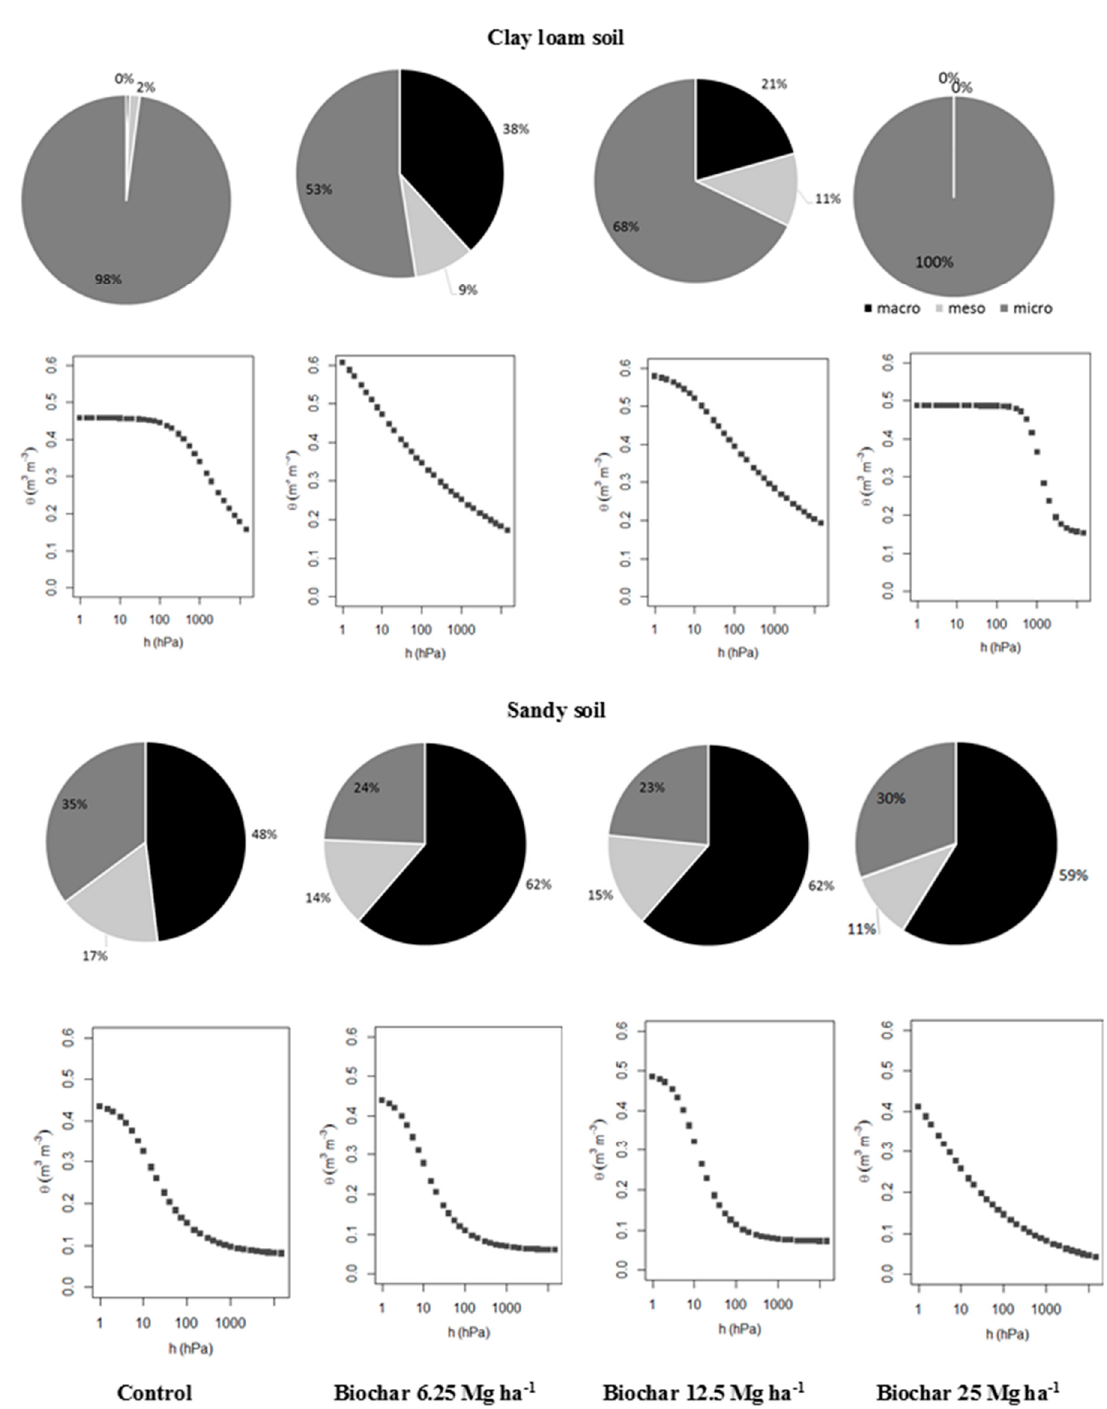
Figure 6. Effect of biochar amount on macropores (>50 µm); mesopores (15–50 µm) and micropores (<15 µm), and its relation with water retention. (<15 µ m), and its relation with water